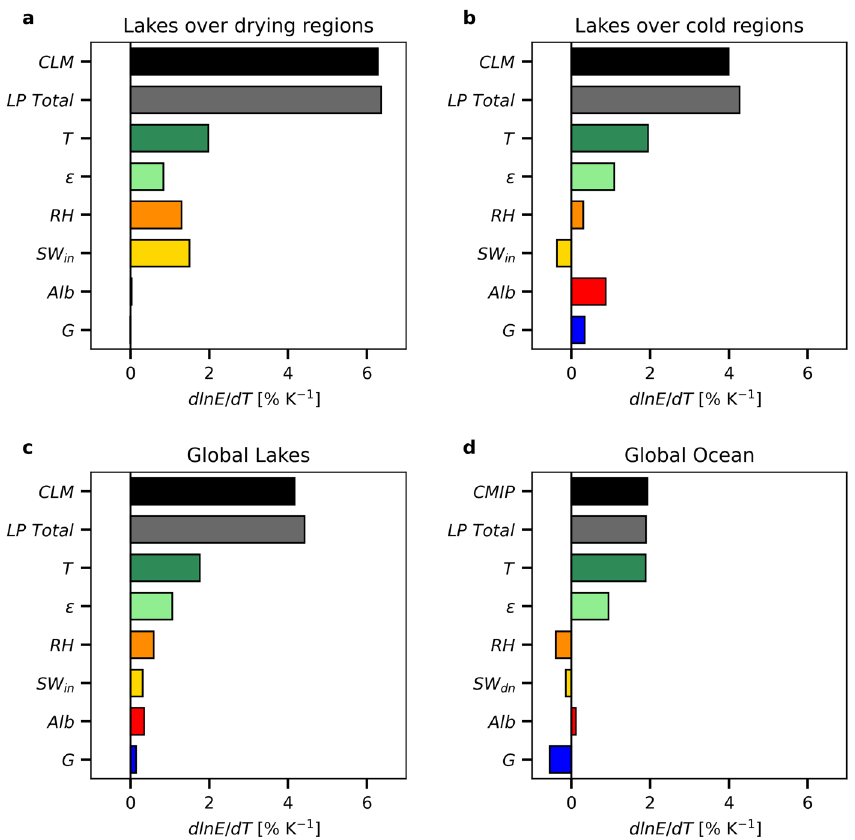
Fig. 3 Drivers of evaporation increase in different regions. a Lakes over the drying regions including tropical America, the Mediterranean and Southeast China. b Lakes over the climatologically cold regions including high latitudes and Tibetan Plateau. c Global Lakes. d Global Ocean. dlnE = dT computes the fractional increase in evaporation with respect to regional surface warming. The black bars show the lake and ocean evaporation increases simulated by models. The gray bars show the evaporation increase estimated by the LP equation. The color bars show the contributions of individual